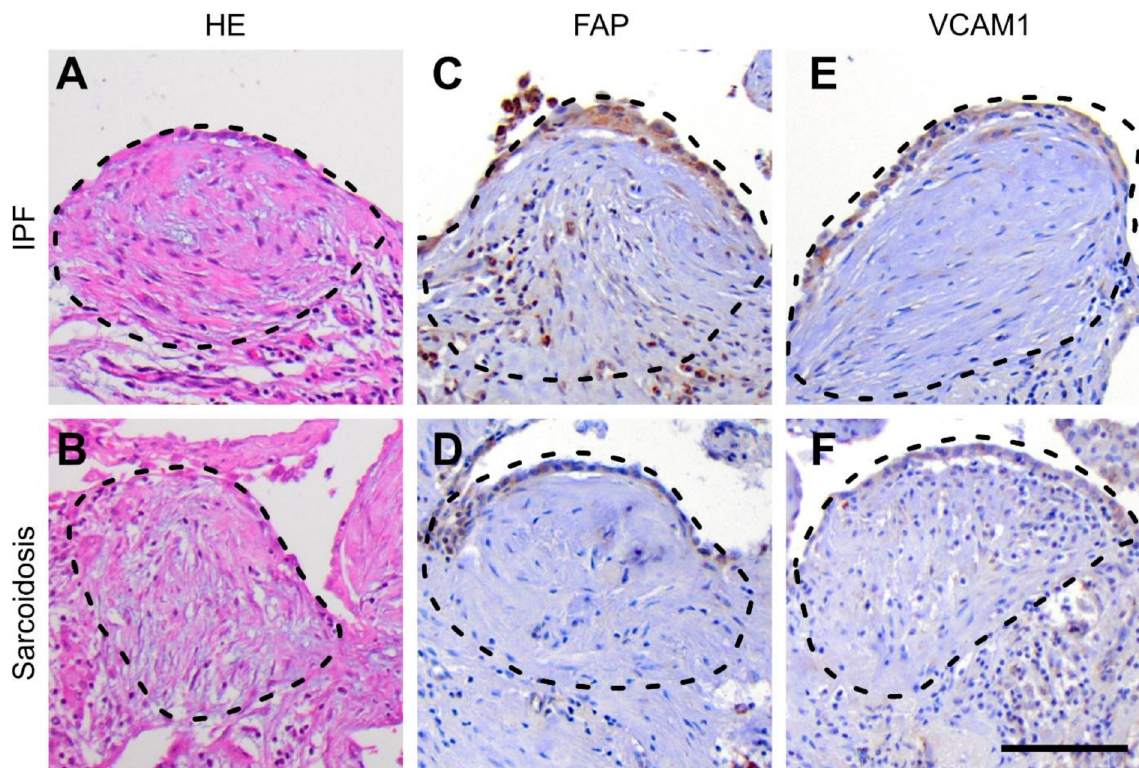
Figure 4. Immunohistochemical staining of fibroblastic foci. Histological morphology of fibroblastic foci (FF), hematoxylin-eosin (HE) stained, in ( A ) idiopathic pulmonary fibrosis (IPF) and ( B ) sar- coidosis showing characteristic myxoid arranged fibroblasts and myofibroblasts, a background of immature extracellular matrix, protrusion into the alveolar space, and a covering epithelial layer of hypertrophied type II pneumocytes; fibroblast activation protein alpha (FAP) showed a coherent staining pattern in FF from sarcoidosis ( C ) and IPF ( D ) lungs with a cytoplasmic enhancement of the covering epithelial layer and a low intensity cytoplasmic staining of scattered myofibroblasts (less pronounced in sarcoidosis); ( E , F ) vascular cell adhesion molecule 1 (VCAM1) showed a specific cytoplasmic enhancement in respiratory epithelial cells and less intensive also in myofibroblasts / connective tissue components (slightly pronounced in sarcoidosis; scale-bar equals 100 µ